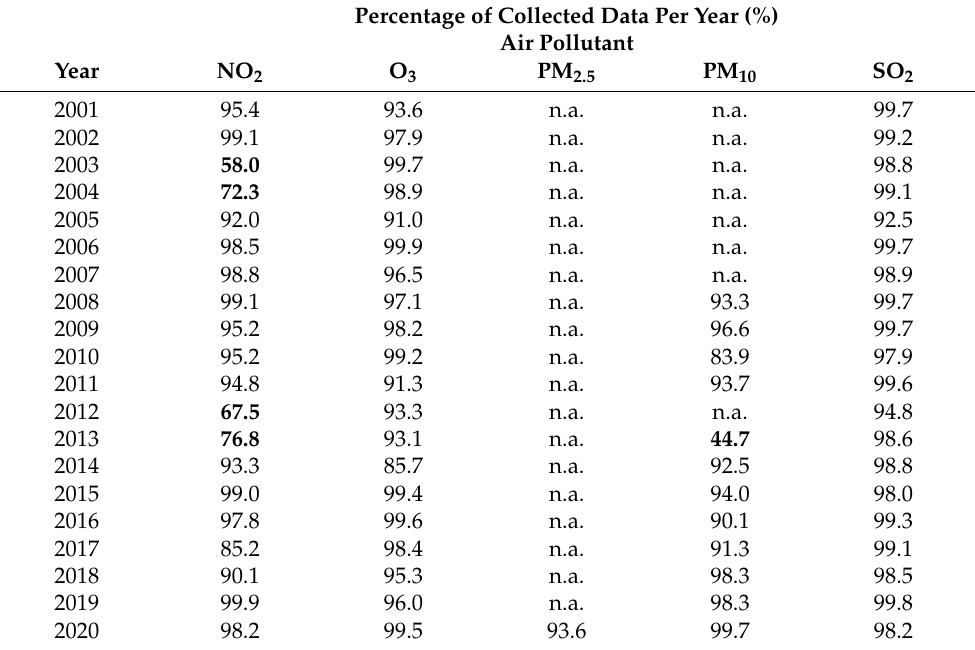
Figure 1. Location of the air quality monitoring station “Paio Pires-Seixal” within Seixal area ( right , red circle) and its location within mainland Portugal ( left ). Table 1. Percentage of the yearly data collected for each pollutant. Bold values refer to a year with a percentage of data collected below